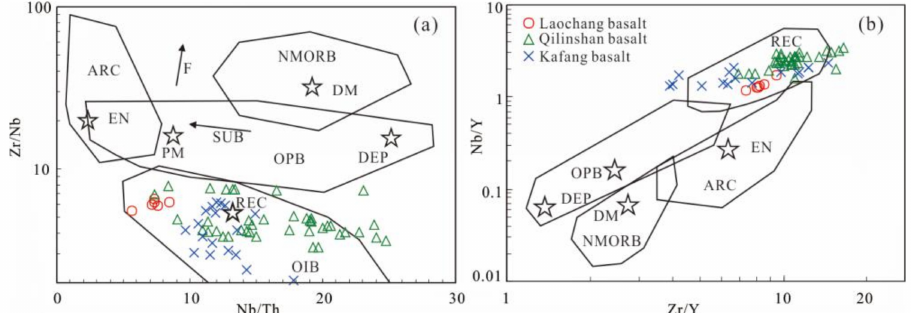
Figure 7. Diagram showing mantle components and fields for basalts from various tectonic settings [40,42]. ( a ) Nb / Th vs. Zr / Nb, SUB: subduction; ( b ) Zr / Y vs. Nb / Y. NMORB: normal mid ocean ridge basalts, DM: depleted mantle, REC: recycled components, EN: enriched, DEP: depleted components, ARC: arc basalts, OPB: oceanic plateau and island basalts. The data of Kafang from [16].